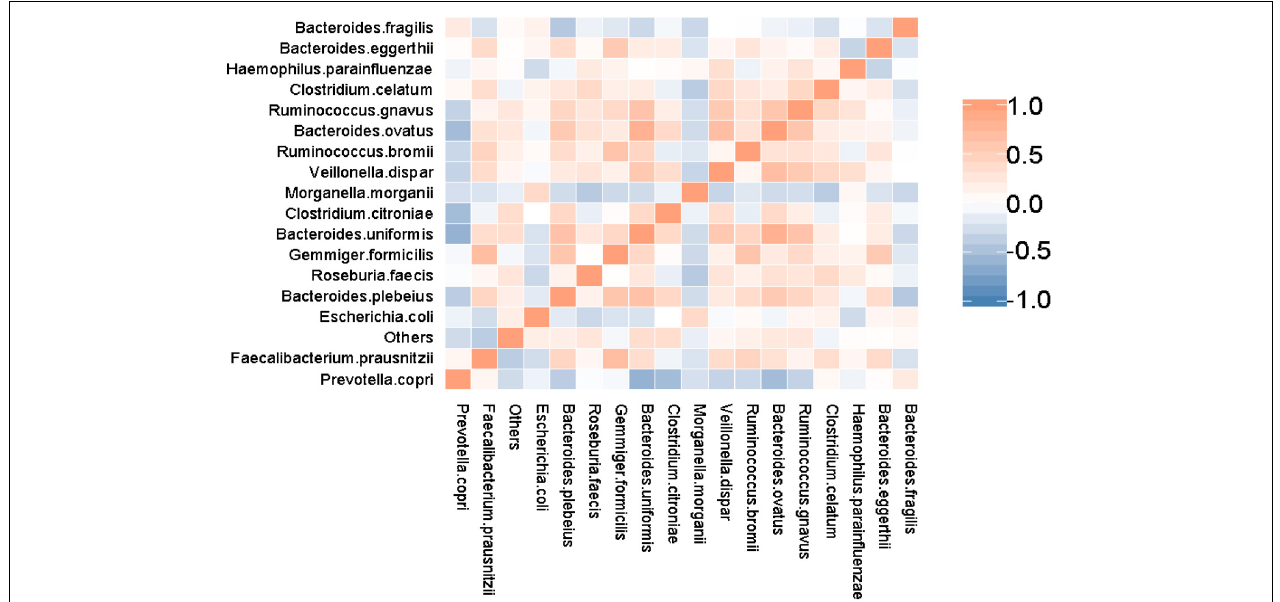
FIGURE 9 | Heatmap showing the results of the association analysis for the SAA and control groups.